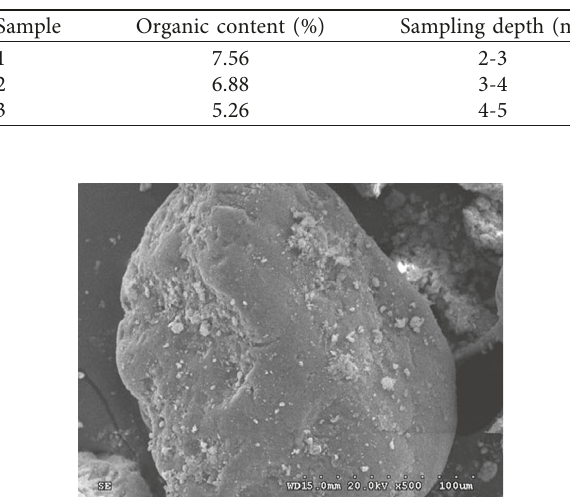
Figure 2: Scanning electron microscopic images of organic sandy